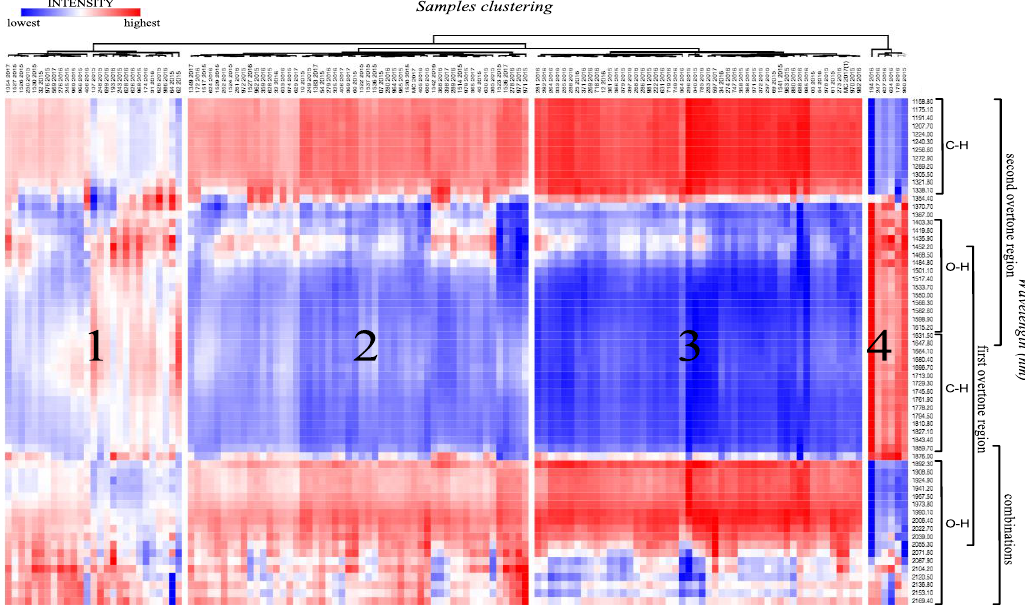
Figure 1. Three-dimensional (3D) dendrogram (sample × wavelength from MicroNIR × intensity) representing the chemical composition similarity relationships among the genotypes.